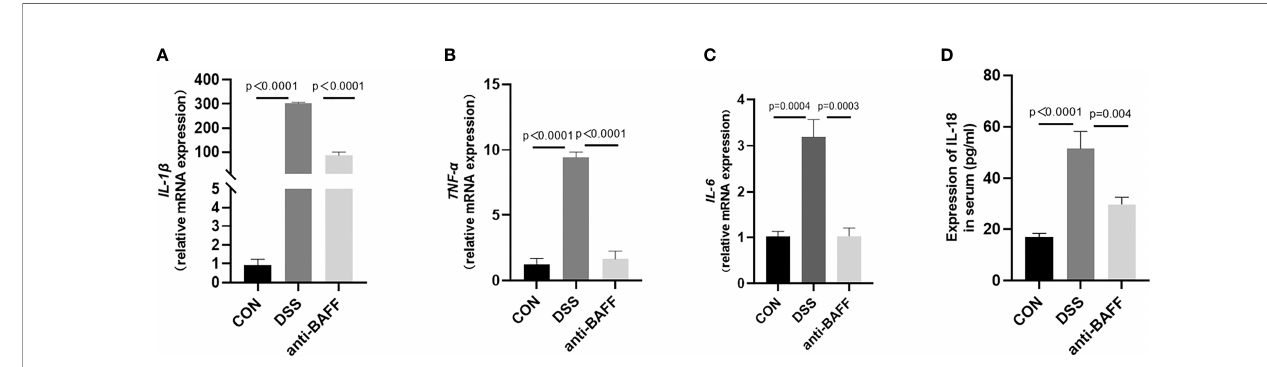
FIGURE 3 | Anti-BAFF antibody decreased colon levels of pro-in fl ammatory cytokines following DSS exposure. (A – D) Total mRNA was extracted from colonic samples to determine the mRNA expression of IL-1 b , TNF- a , and IL-6 by RT-qPCR, and IL-18 of serum concentrations by